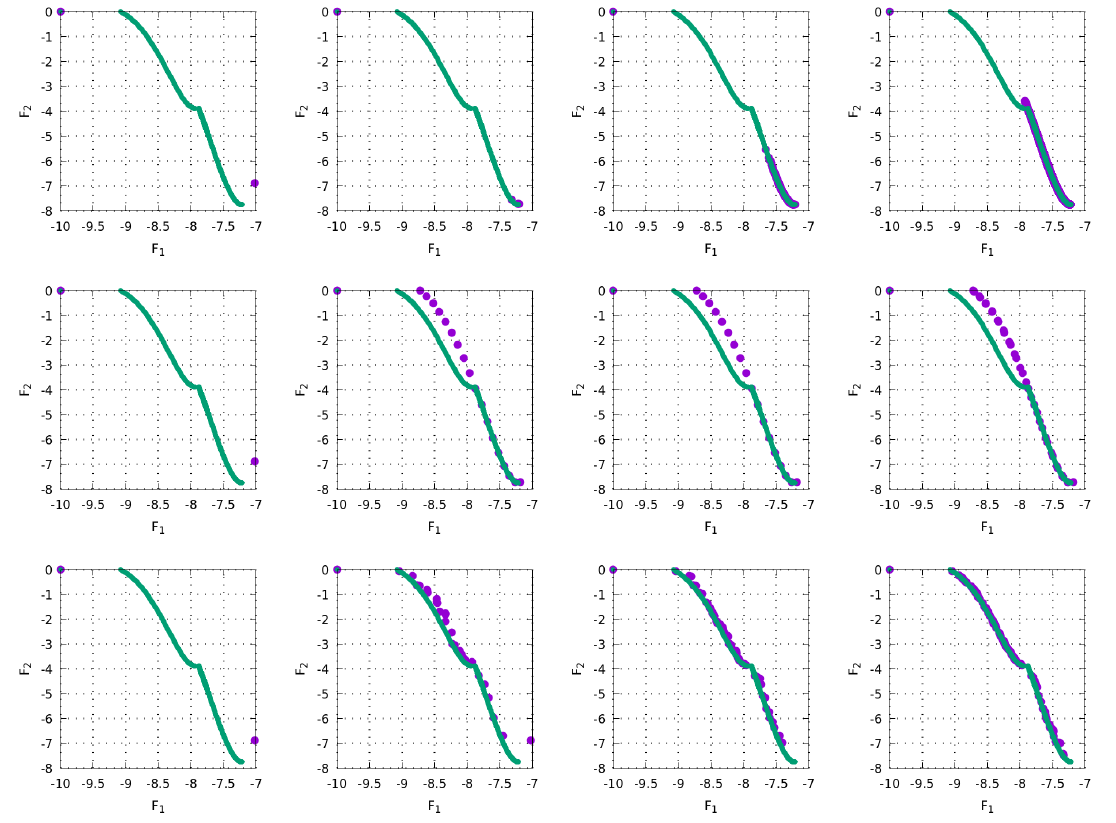
Figure 1. Pareto front approximation obtained by using the three methodologies separately. From top to bottom, the results obtained by applying only local resampling ( top ), Pareto front interpolation ( middle ) and NBI ( bottom ). From left to right, four different stages of evolution of the methodology. Green dots are the true Pareto